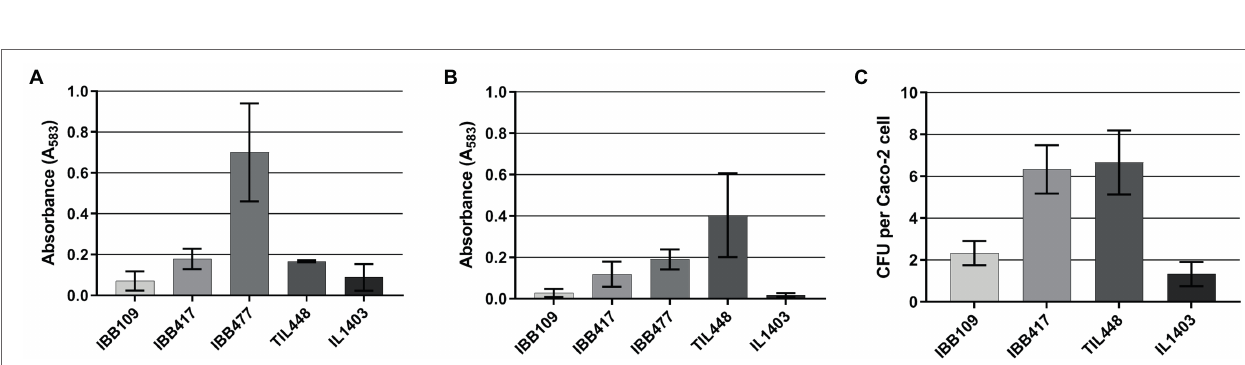
FIGURE 5 | In vitro adhesion of L. lactis IBB109 and IBB417 strains to (A) abiotic and (B) biotic surfaces and to (C) Caco-2 cells. Adhesion to bare polystyren (abiotic) and mucin-coated polystyrene (biotic) microplates is expressed as optical density (OD 583 nm) of stained cells. Adhesion to Caco-2 cells is expressed as the number of viable adherent bacterial cells (CFU) per single Caco-2 cell. The mean values ± SD from three independent experiments are shown. Control L. lactis strains: IL1403 non-adherent strain (negative control); TIL448 adherent strain to mucin and IBB477 adherent strain to bare polystyrene (positive